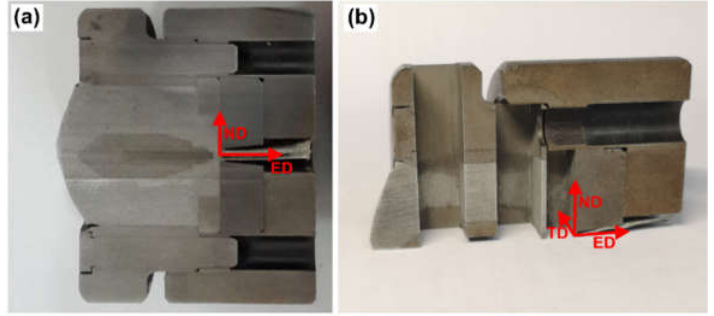
Figure 2. The observation section of the metal flow: ( a ) longitudinal section, and ( b ) cross